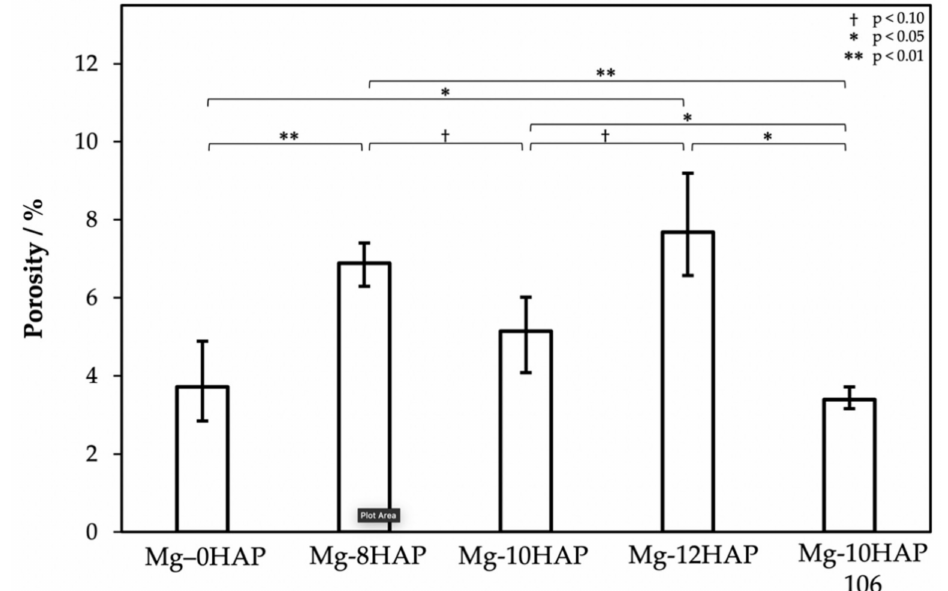
Figure 3. The porosities of each composition showing no dependency on the HAP volume fraction. Comparing Mg–10HAP and Mg–10HAP106, it was found that the smaller magnesium grains are, the smaller the porosity